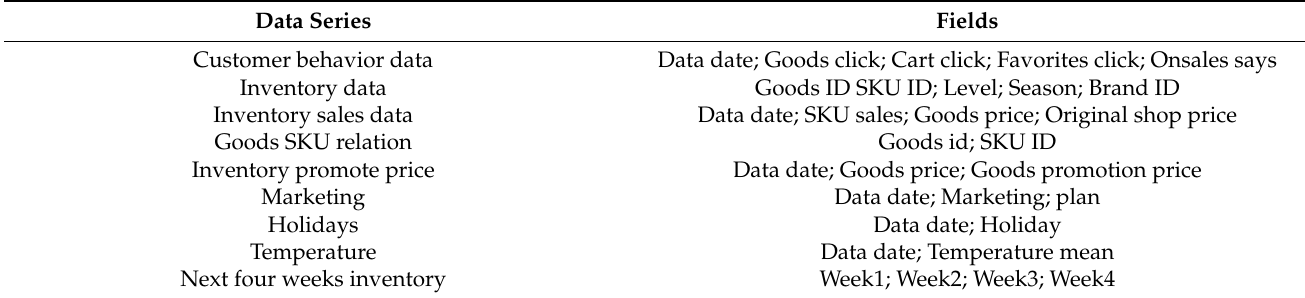
Table 1. Data series of the product.